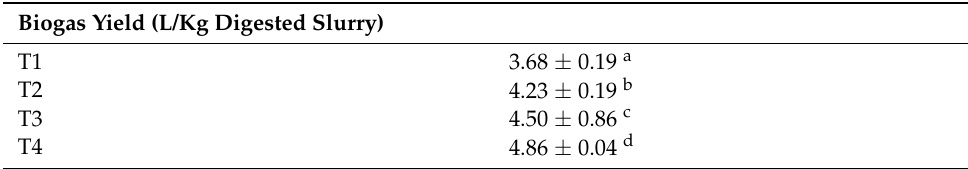
Table 6. Biogas production during post digestion